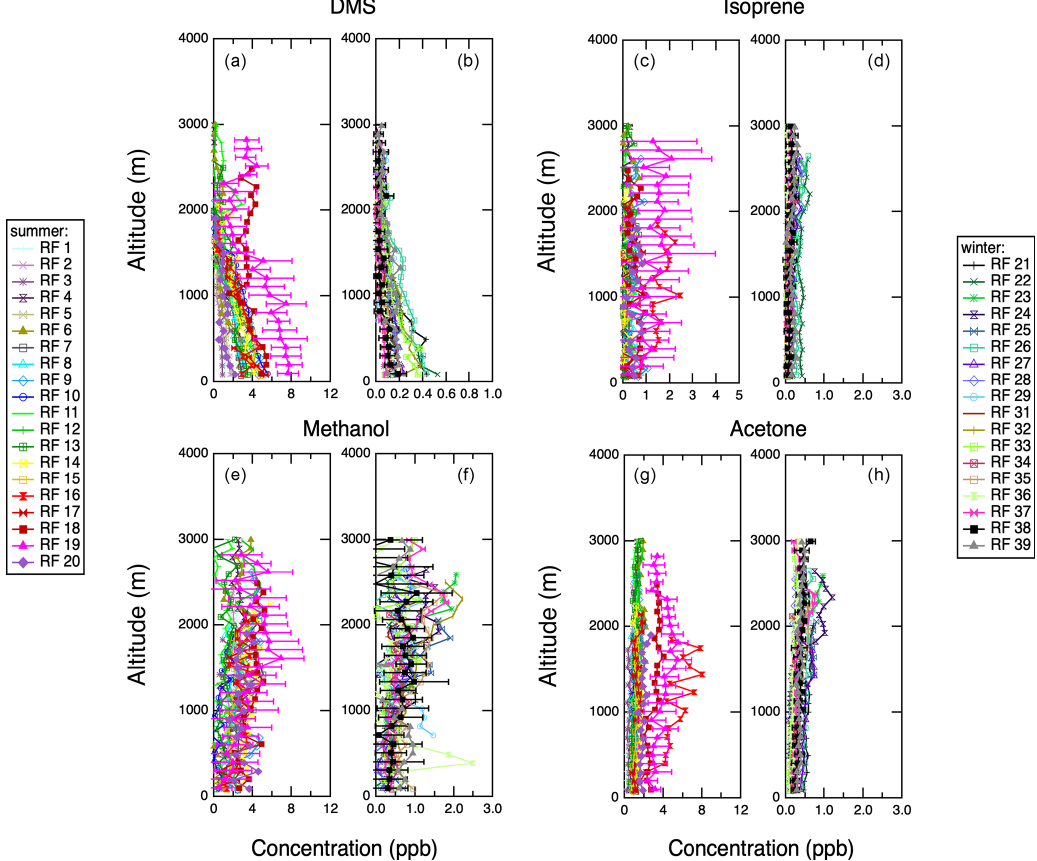
Figure 11. Vertical profiles of PTR-MS trace gas chemistry measurements acquired during spiral profiles shown in Fig. S1. Representative error bars (1 σ standard deviations) are shown on 1d only for clarity. (a) Dimethyl sulfide, IOP 1. (b) Dimethyl sulfide, IOP 2. (c) Isoprene,